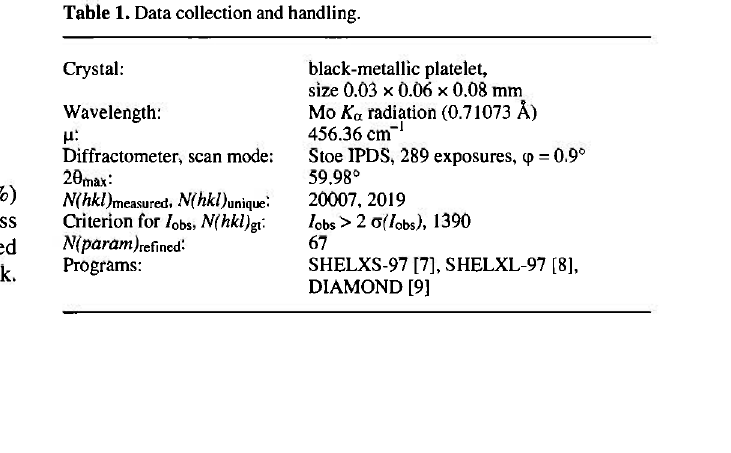
Table 1. Data collection and